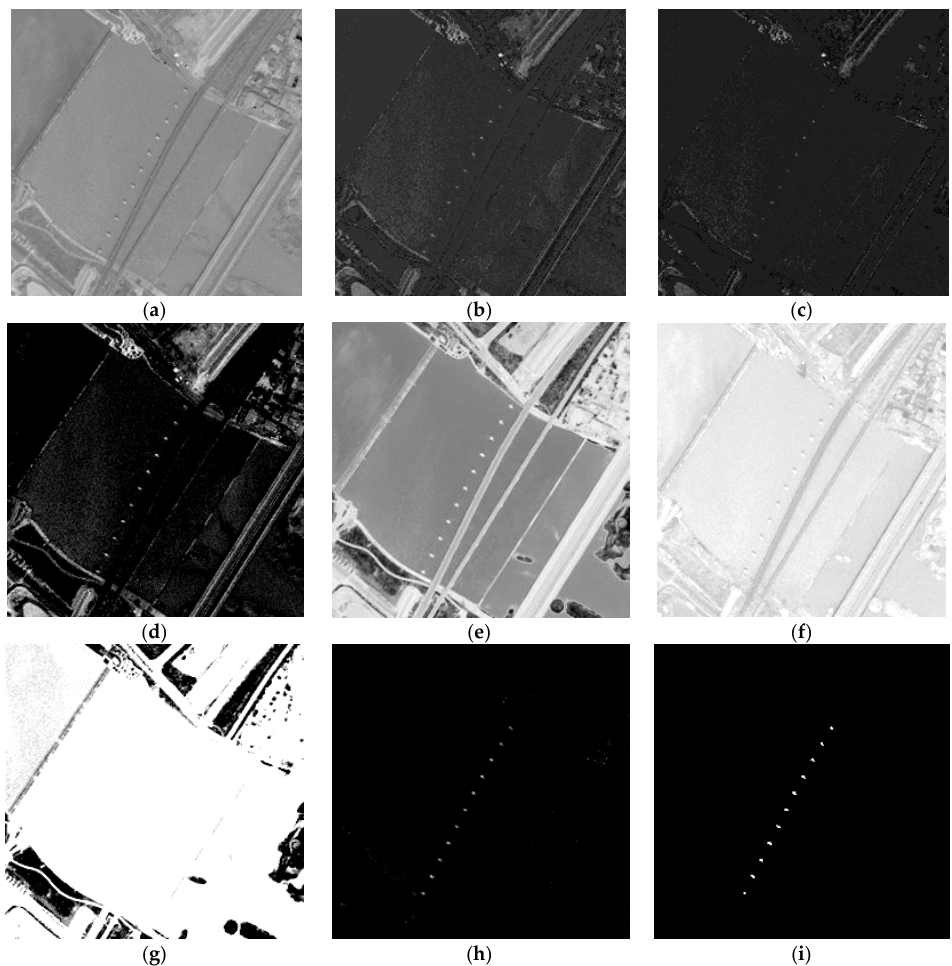
Figure 7. Detection results of the Chanba Area: ( a – c ) results of the hCEM algorithm for the first to third layers; ( d ) results of CEM algorithm; ( e ) results of SAM algorithm; ( f ) results of CE algorithm; ( g ) results of MPCEM algorithm; ( h ) results of SWCEM algorithm; and ( i ) reference data.